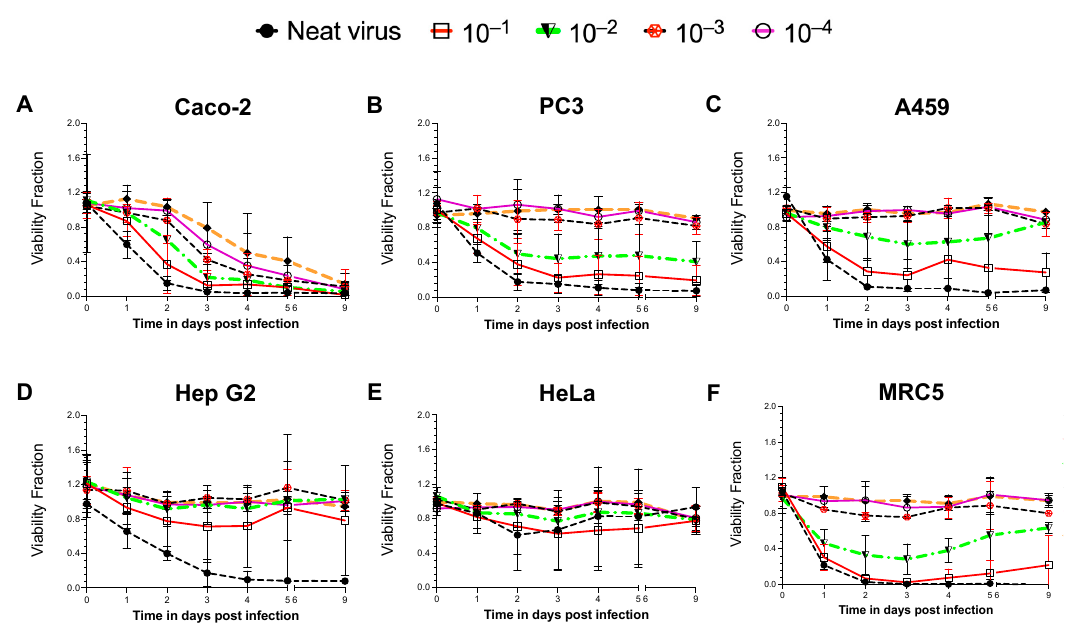
Figure 1. Time- and NDV dose-dependent cell viability assay in different human cancer cells. Cell lines were infected with a neat virus (MOI of 50) of a non-pathogenic reporter strain of NDV B1-GFP and its 10-fold dilutions. Cell lines derived from different cancerous tissues such as ( A ) the colon (Caco-2), ( B ) prostate adenocarcinoma cells derived from the metastatic site in bone (PC3), ( C ) lung (A549), ( D ) liver (Hep G2), ( E ) cervix (HeLa) and ( F ) non-cancerous human lung fibroblast cells (MRC5) were used for the study. Cell viability was measured throughout nine days of infection study. Data (mean ± SD) represented here is the combination of three repeats for each cell line. Viability Fraction = Normalised fluorescence reading of infected cells at (560 Ex/590 Em)/Normalised fluorescence reading of uninfected cells at (560 Ex/590 Em).